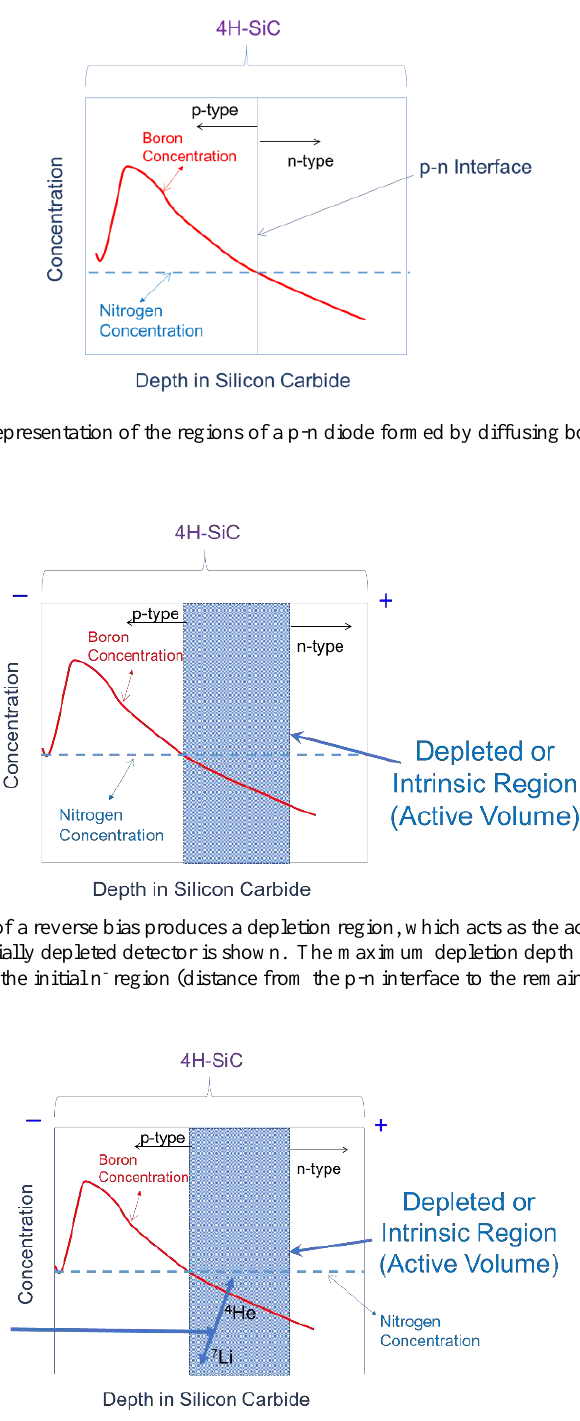
Fig. 3. A thermal neutron can interact with a 10 B nucleus within or adjacent to the depleted region to form energetic 4 He and 7 Li ions, which will produce ionization in the detector active volume.